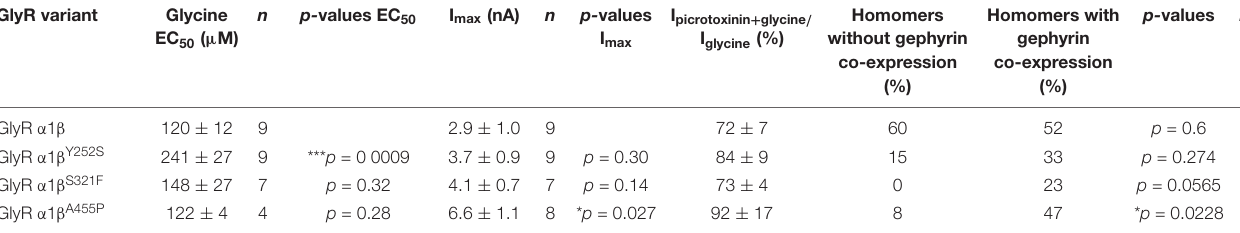
FIGURE 6 | GlyR functional properties do not change in the presence of gephyrin. (A) Verification of heteromeric receptor configuration using picrotoxinin block. GlyR α 1 β WT and α 1 β x variants were co-expressed with eGFP-gephyrin in HEK-293 cells. The remaining current (%) upon co-application of 100 µ M glycine and 100 µ M picrotoxinin compared to 100 µ M glycine alone is shown. Dotted blue line at 50% picrotoxinin block divides between homomeric (below blue line) and heteromeric (above blue line) receptor configuration. (B) Stack plot of the ratio between homomeric (green) and heteromeric (black) receptor configurations of α 1 β WT and α 1 β x variants in the absence and presence of eGFP-gephyrin. Significance value * p < 0.05. (C) Glycine-activated currents at saturating glycine concentration (1 mM). Note, the GlyR β A455P variant again exhibited significantly increased I max values. (D) EC 50 values for α 1 β WT and α 1 β x variants in the presence of eGFP-gephyrin were determined following application of a concentration series of glycine (10, 30, 60, 100, 300, 600, and 1,000 µ M). (E) Dose response curves of α 1 β Y252S shows a rightward shift to higher glycine concentration compared to α 1 β WT in the presence of eGFP-gephyrin. * p < 0.05, *** p < 0.001. TABLE 4 | Physiological measurements of α 1 β and α 1 β x variants in the presence of gephyrin in transfected